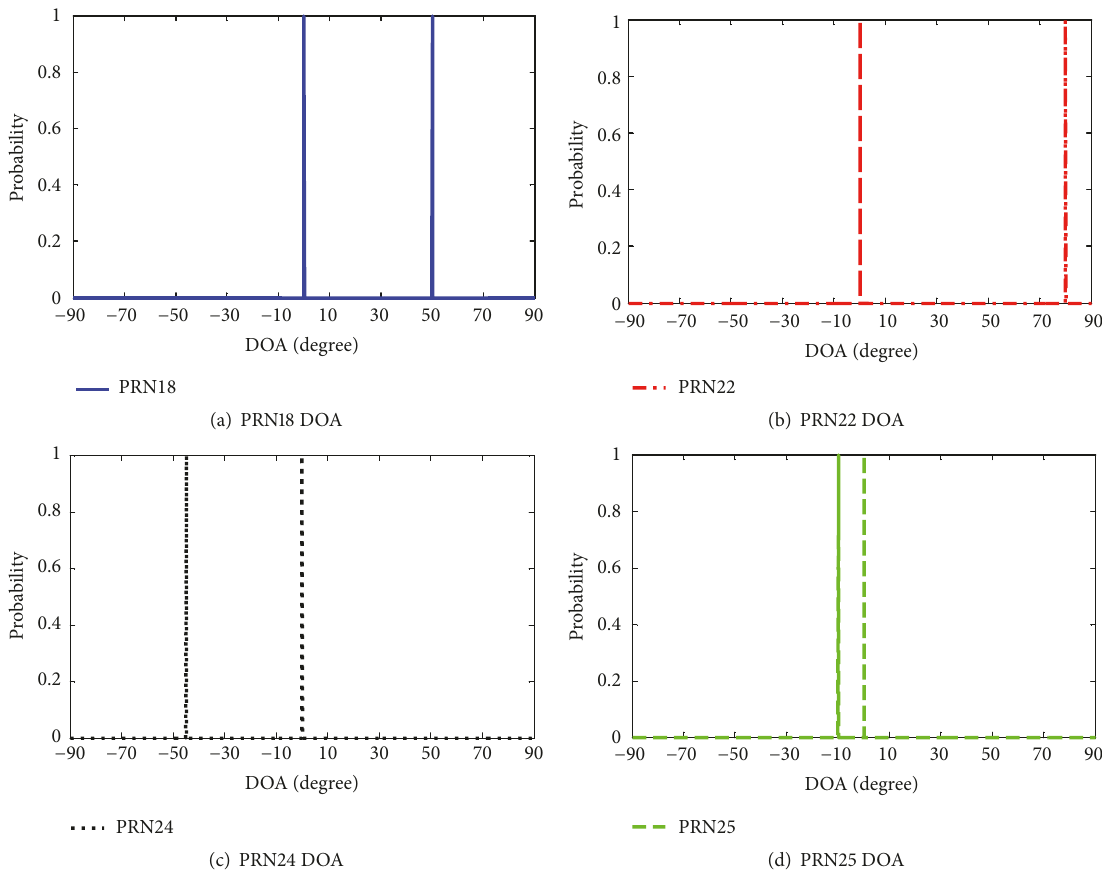
Figure 4: DOA estimation of satellite (a) DOA of PRN18; (b) DOA of PRN22; (c) DOA of PRN24; (d) DOA of PRN25.